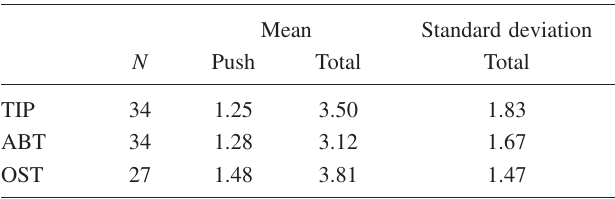
TABLE I. Pretest data. Tutorial populations are reported as well as the mean and standard deviation of the number of facets students used. The mean number of facets used on pushing questions is also reported, as it will impact the analysis of our examination data. No statistically significant differences are evident among the pretest results between each of the